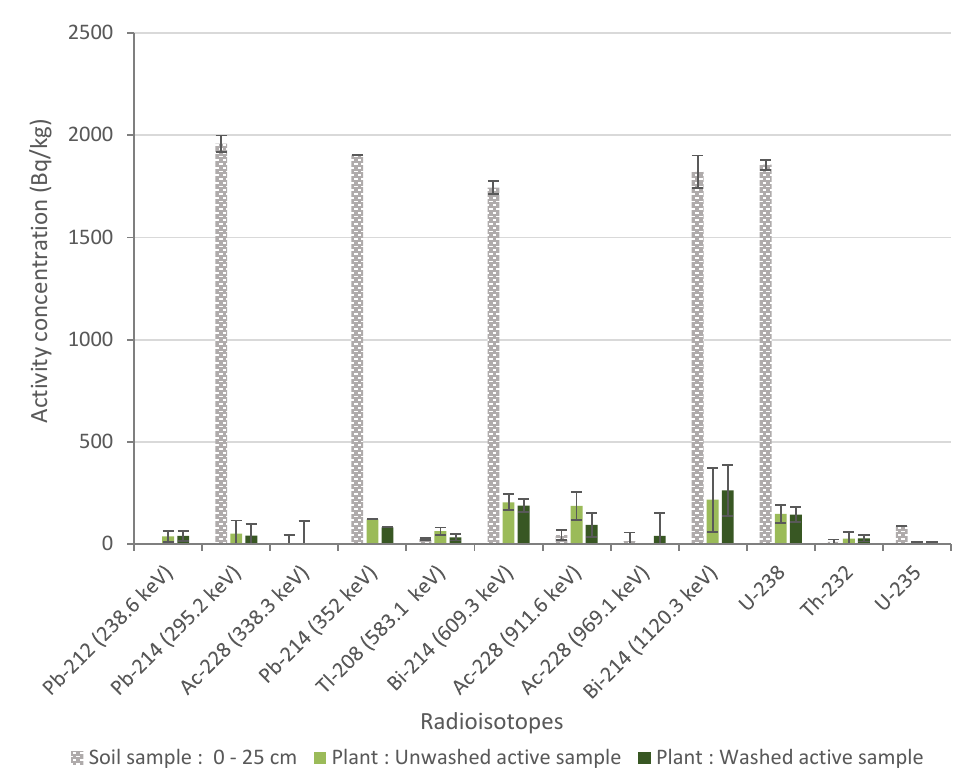
Table 2. Transfer factors calculated from 0 – 25 cm soil samples.